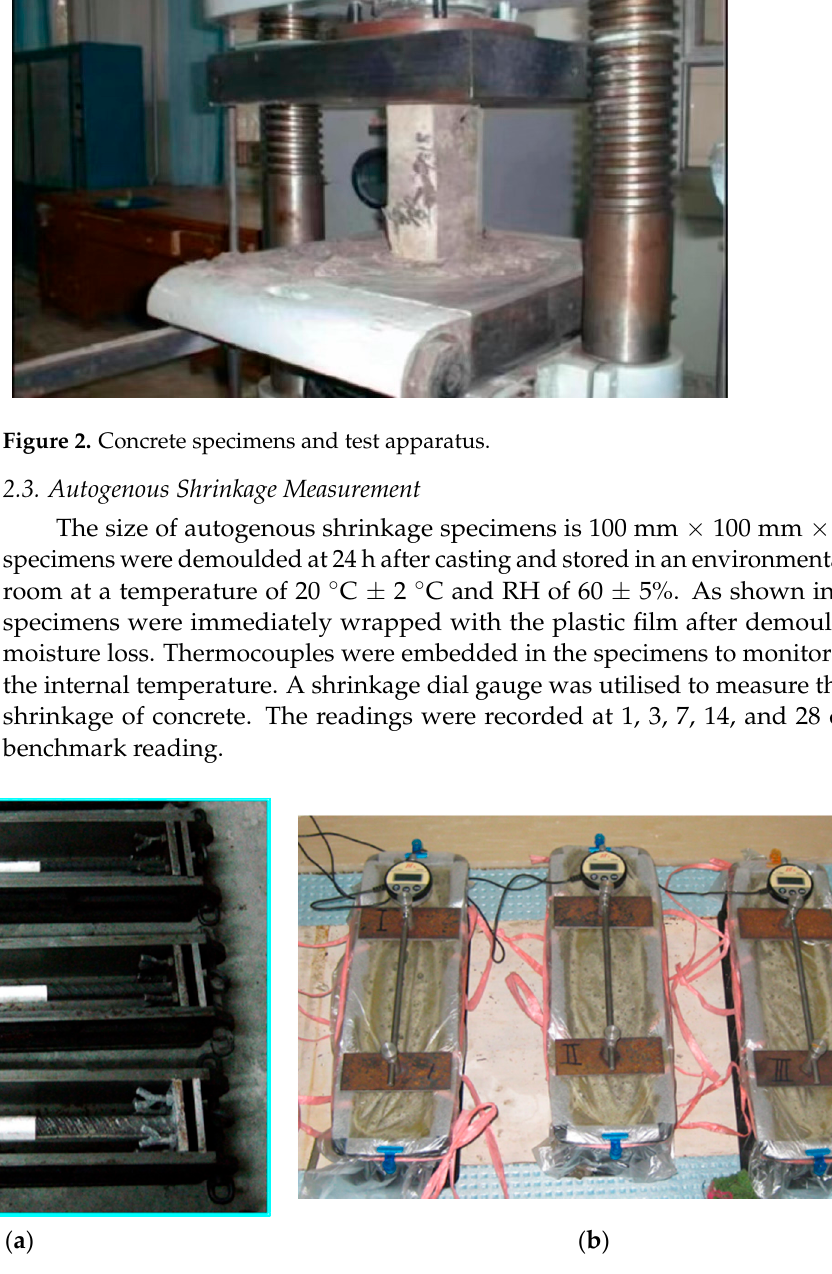
Figure 3. Autogenous shrinkage of concrete: ( a ) shrinkage mould; ( b ) specimens.